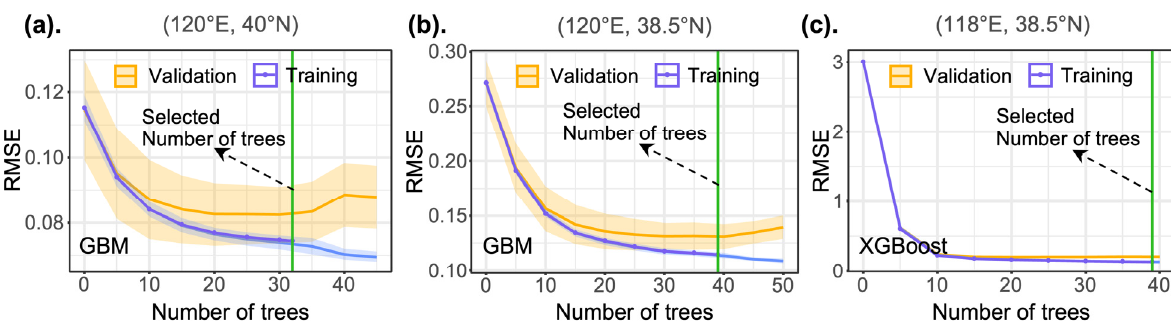
Figure 6. H2O-AutoML learning curve at 4th ( a ), 23rd ( b ) and 19th ( c ) coordinate